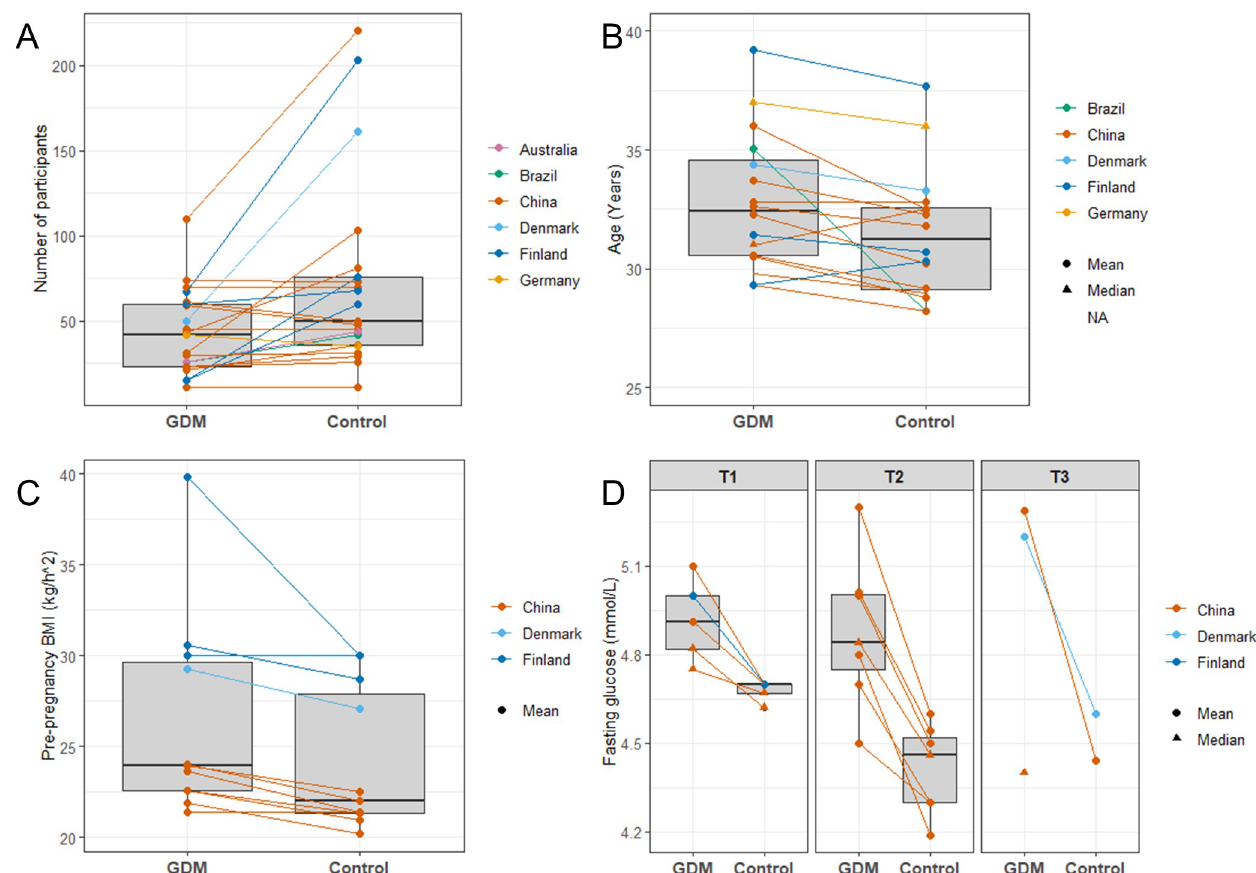
Fig 3. Box plots comparing GDM and non-GDM women in the included studies. (A) Number of participants, (B) Age, (C) Pre-pregnancy BMI, and (D) Fasting glucose measured in the different trimesters of pregnancy. T1, first trimester; T2, second trimester; T3, third